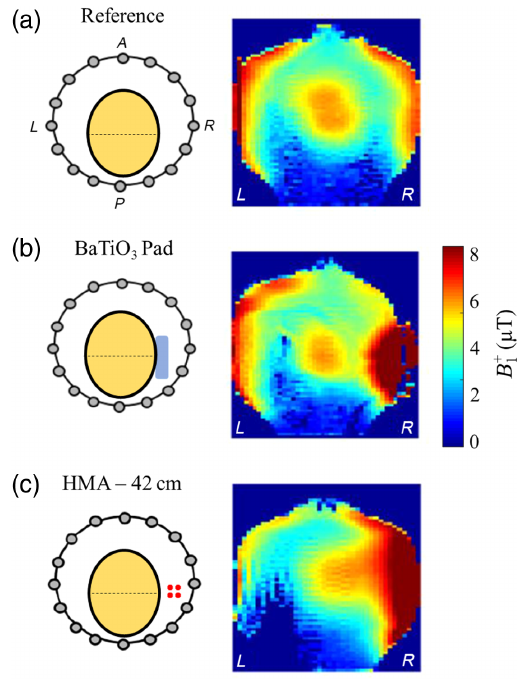
FIG. 7. SNR measurement with and without HMA on SAM 6. (a) – (c) Left: Schematic view of the experimental phantom. (a) Proton density weighted (PDW) coronal image with configurations inside the 7 T MRI: birdcage legs in gray circles, birdcage and (b) with 42-cm-long HMA inserted (metamaterial specific anthropomorphic mannequin (SAM) in yellow, position- along the right-hand side of the phantom). Local enhancement ing of the BaTiO 3 pad in blue (b) and HMA in red dots (c). The can be visually identified by the white arrow along the HMA. horizontal dotted line shows the imaging plane. Right: Measured (c) Corrected SNR maps (arbitrary units) obtained with the B þ μ T) of the SAM phantom: (a) with SAM 1 coronal maps (in birdcage alone and (d) in presence of HMA. (e) Calculated only, (b) in the presence of a BaTiO 3 pad on the right-hand side, SNR enhancement map in percentage. It confirms a strong SNR and (c) replacing the pad with a 42-cm-long HMA. HMA is enhancement close to the HMA but also a slight improvement on located 2 cm away from the a relatively large part of the phantom